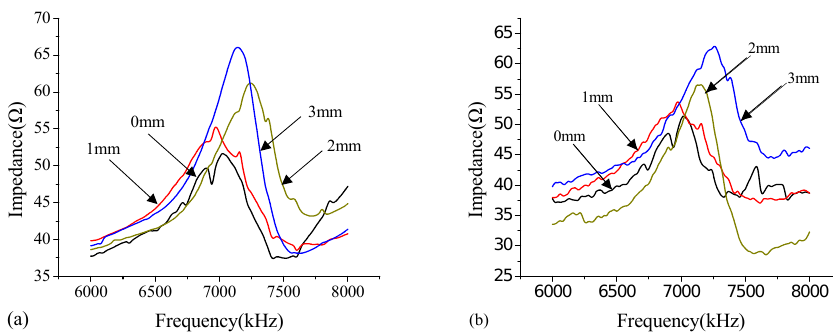
Figure 5. Impedance curves of PZT sensors bonded on the steel plate surface of the B ‐ type specimen under the excitation frequency bands of ( a ) 6000–8000 kHz; ( b ) 10,000–12,000 kHz; Impedance curve of PZT sensors bonded on the UHPC surface of the B ‐ type specimen under the excitation frequency bands of ( c ) 6000–8000 kHz; and ( d ) 10,000–12,000 kHz.